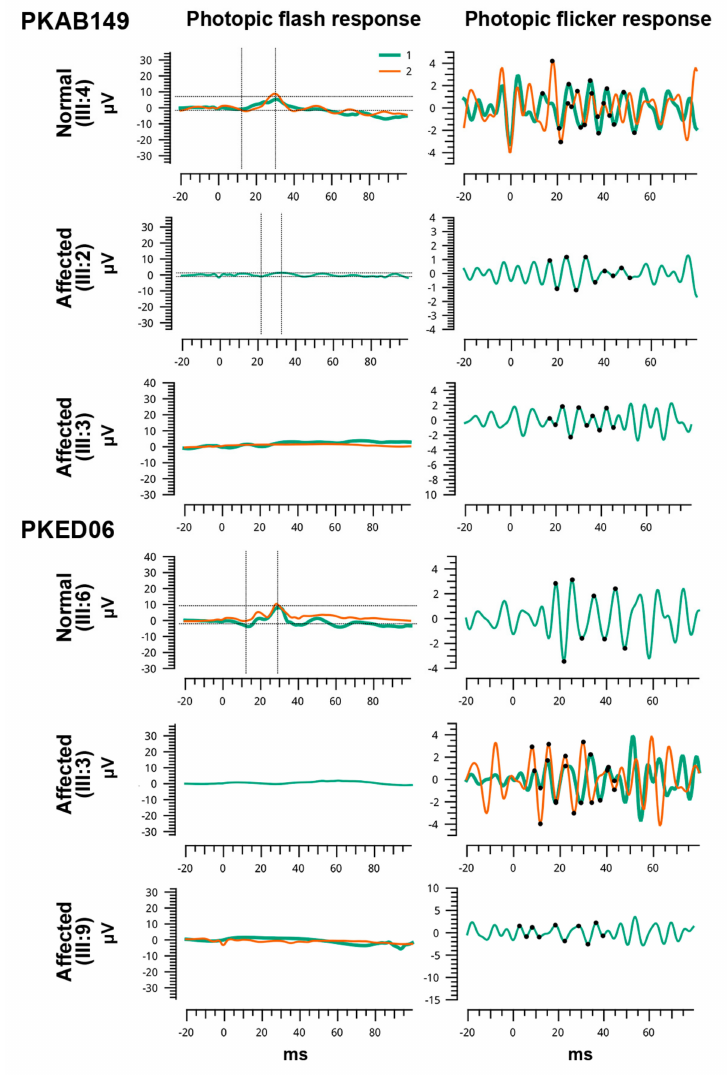
Figure 3. Shown are the full-field ERG photopic responses of two normal and four affected individuals homozygous for CNGA3 identified known missense variants. In order to show reproducibility, two responses (green and orange) have been superimposed for each ERG condition. ERG responses of affected individuals of both families revealed severe reduction in photopic